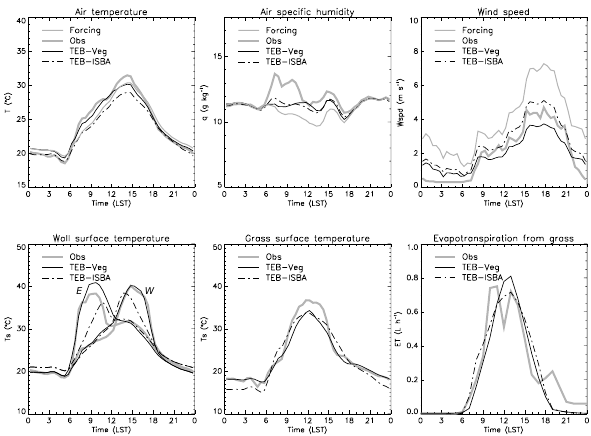
Fig. 6. Same as Fig. 5 for the Exposed-Grass